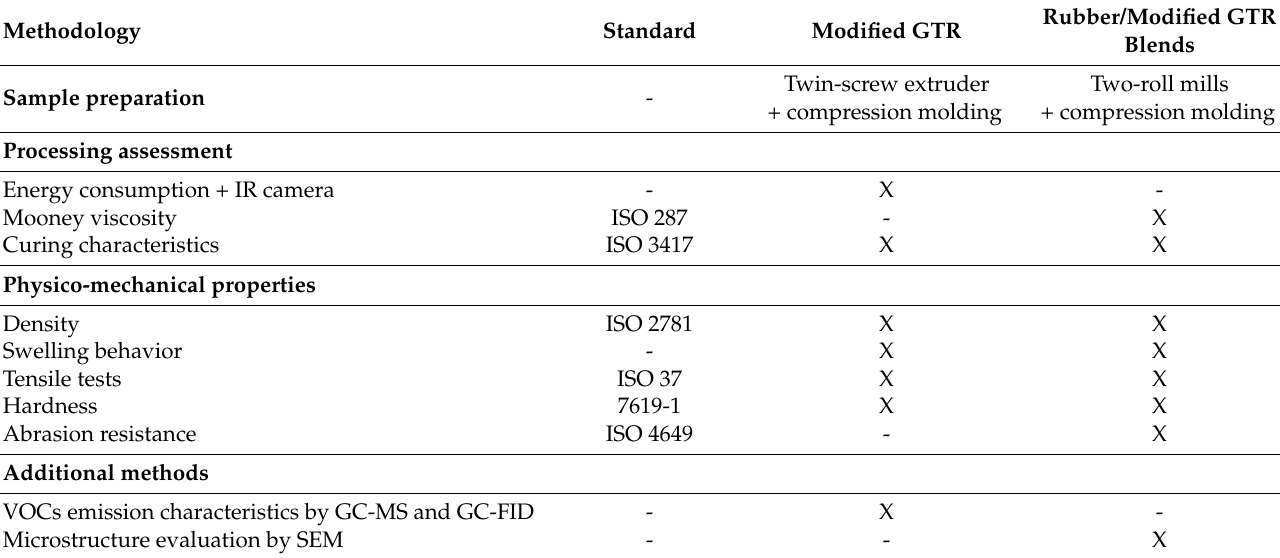
Table 2. Sample preparation protocol and methodology used for modified GTR and rubber/modified GTR blends.